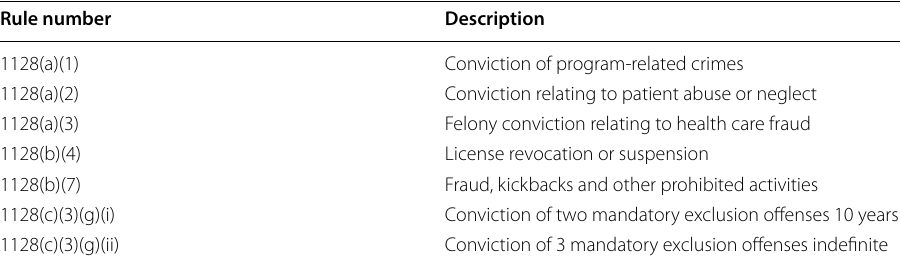
Table 5 LEIE rules involving